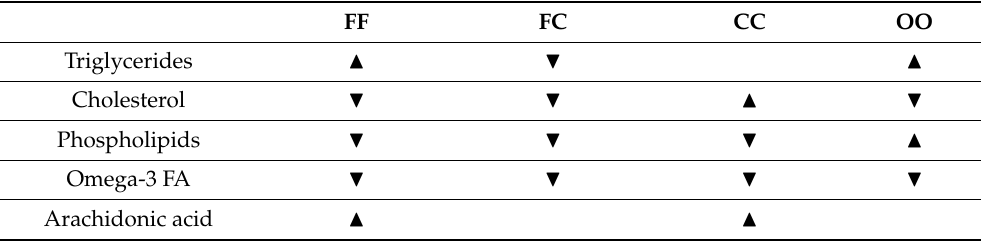
Table 1. Differences in apolar metabolite content between seasons in follicular fluid (FF), follicular cells (FC), cumulus Cells (CC), and oocytes (OO). (cid:78) higher concentration in the NBS vs. BS; (cid:72) lower concentration in the NBS vs.